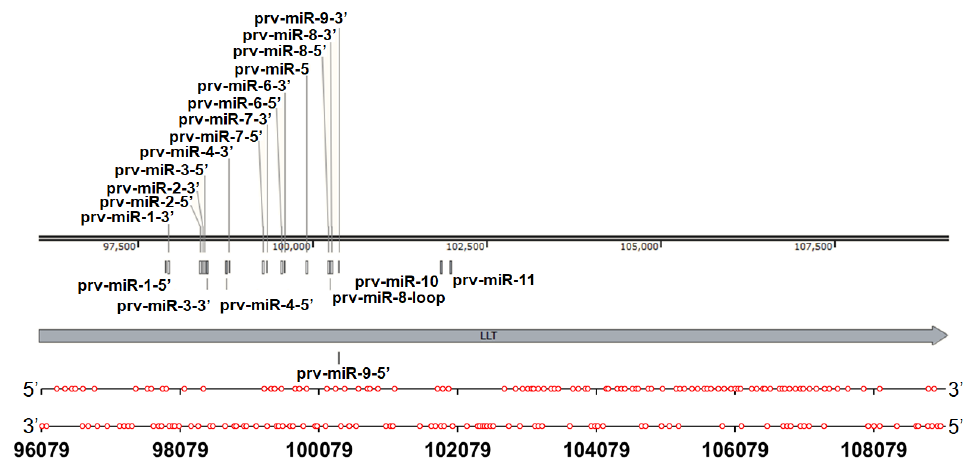
Figure 8. Distribution of G 2 -PQSs in the double-strands of the PRV large latency transcript region. One red circle indicates one G 2 -PQS.